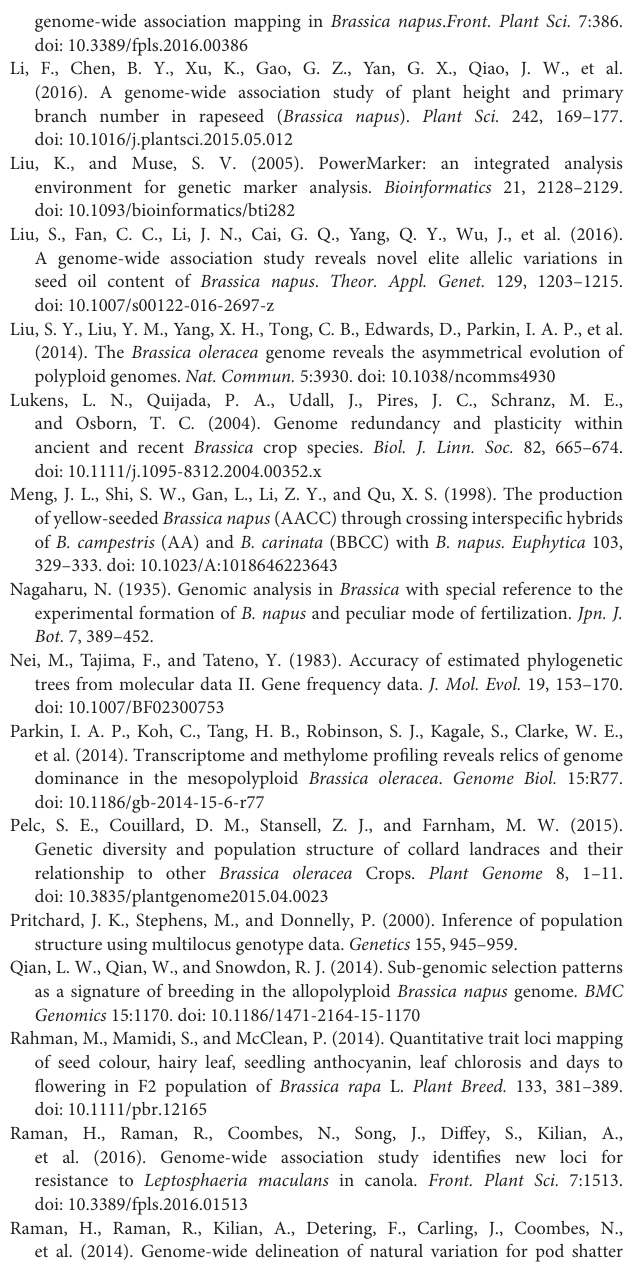
Supplementary Table 1 | Accessions of B. carinata investigated in this study. Supplementary Table 2 | Details of field experiments across multiple environments. Supplementary Table 3 | The genetic linkage map of the YW DH population. Supplementary Table 4 | The distribution of L(K) and Delta K of population structure analysis. Supplementary Table 5 | The identified and consensus QTL for 14 traits investigated in the YW DH